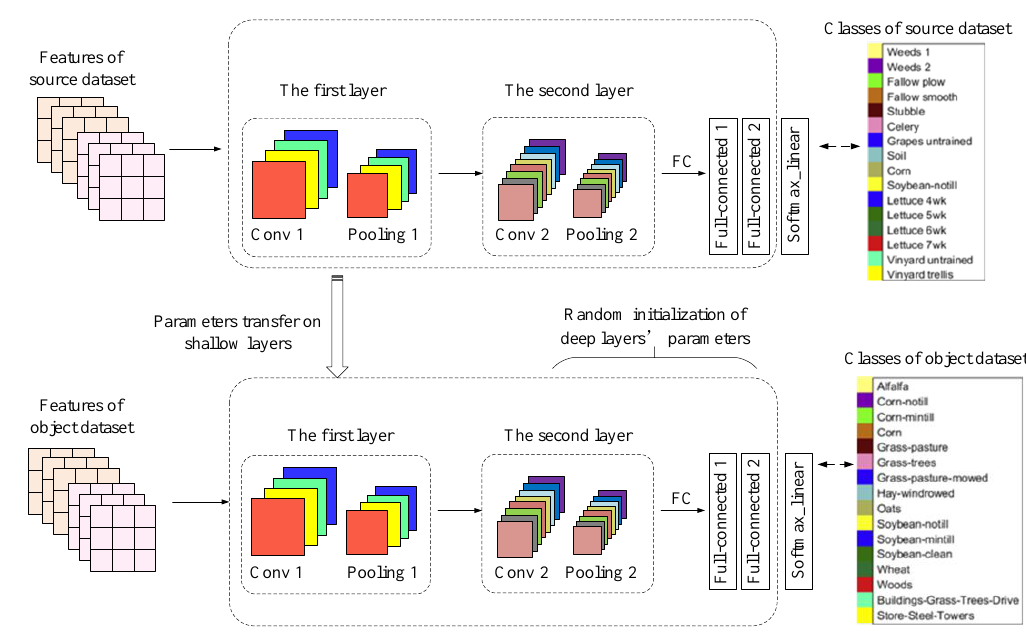
Figure 6. Principle of hyperspectral image classification based on deep transfer learning.